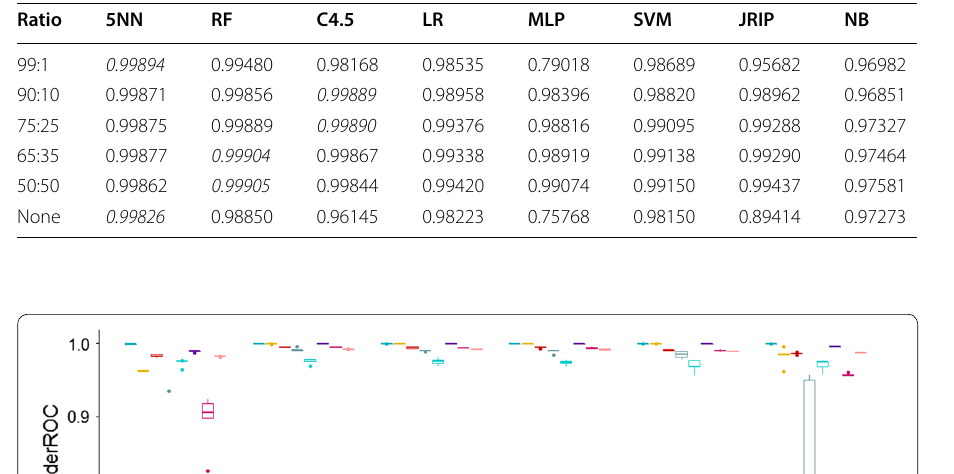
Table 2 Cross validation results